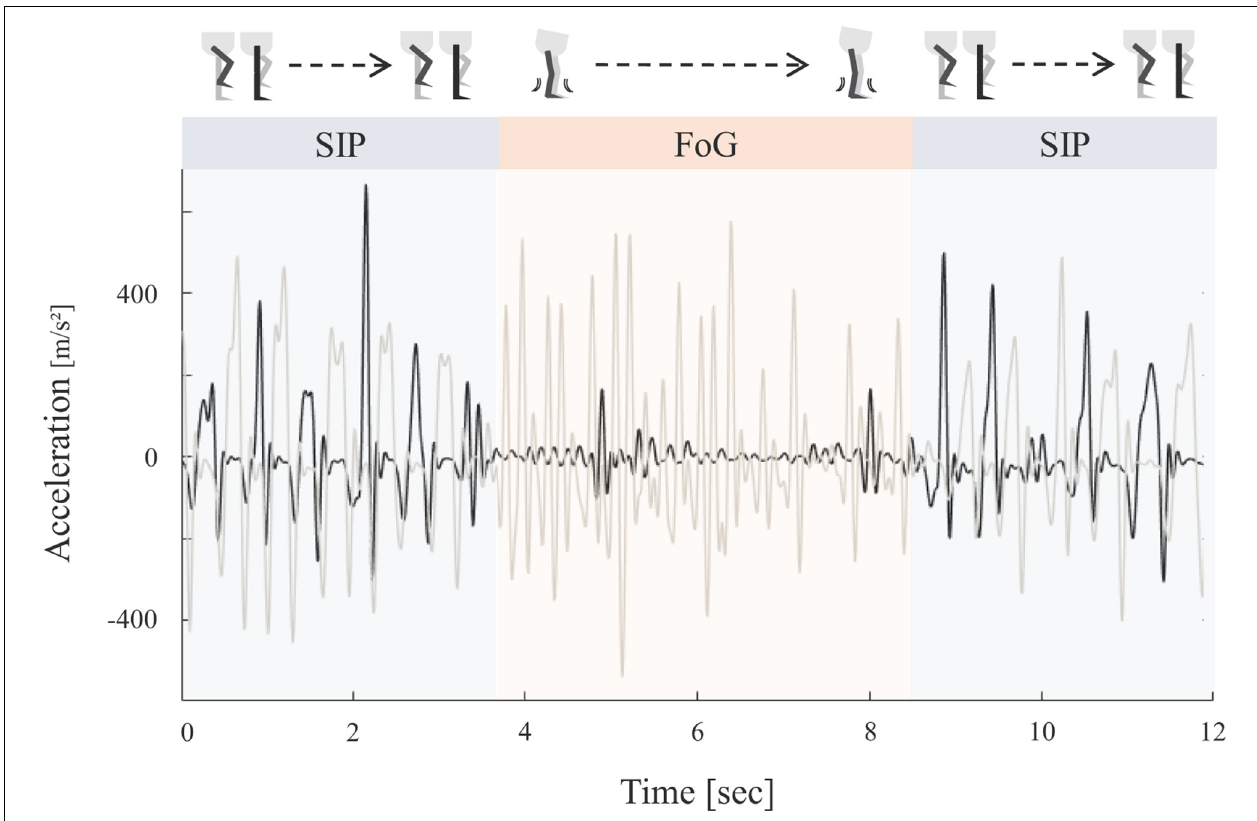
FIGURE 1 | Schematic representation of the stepping in place (SIP) task and corresponding accelerometer curves. Example of vertical accelerometer signals of both legs (black = right leg, gray = left leg) during continuous SIP interrupted by a freezing episode. Effective stepping was characterized by alternating heel strikes. Freezing episodes were defined by high frequency low amplitude oscillations reflecting leg trembling during freezing of gait